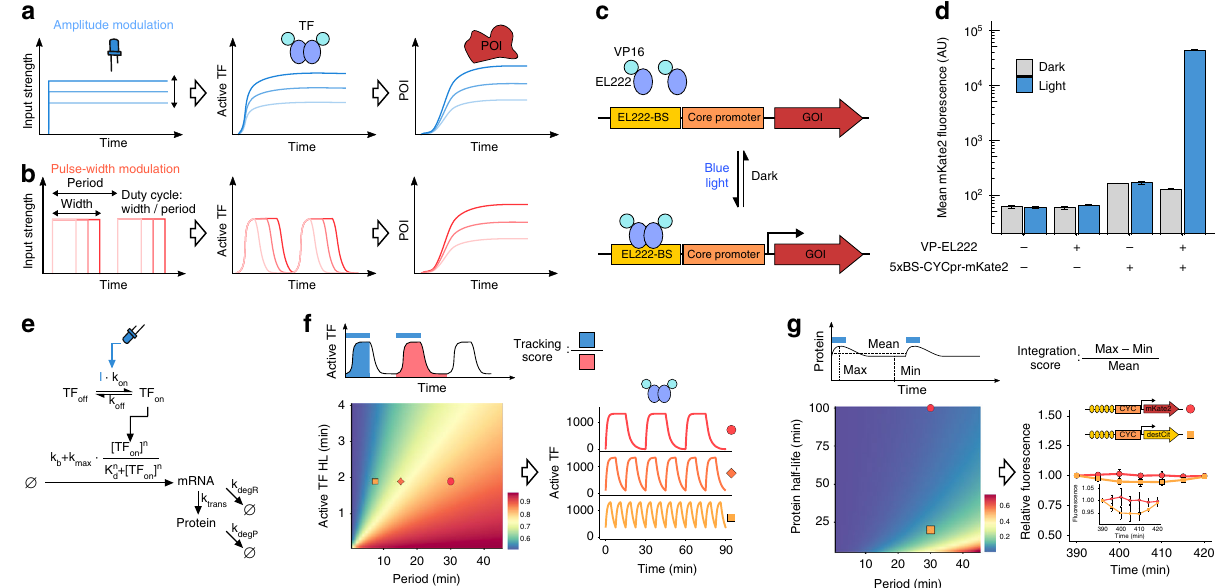
Fig. 1 Characterization of an EL222-based optogenetic gene expression system in S. cerevisiae . a and b Schematic of gene expression regulation by AM ( a ) and PWM ( b ). Input signals (left) lead to TF activation (middle) and expression of a protein of interest (POI, right). c Illustration of the optogenetic gene expression system. Blue-light triggers VP-EL222 dimerization and transcription of a gene of interest (GOI). d Effect of blue-light illumination on VP- EL222 mediated gene expression. Strains, with or without the VP-EL222 and a reporter construct (5xBS- CYC180 pr-mKate2), were grown either in the dark or under illumination (460 nm, 350 µ W cm − 2 ) for 6 h. Data represent mean and s.d. of three independent experiments. e Graphical representation of the model describing VP-EL222 mediated gene expression. I represents the light input. See Methods and Supplementary Note 1 for details. f Model-based analysis of pulsatile TF behavior. To quantify the temporal TF response, we use a tracking score de fi ned by the ratio between the integrated TF activity during the light pulse and the whole period (top, Supplementary Note 2). This metric is 1 if the TF activity perfectly tracks the input, and equals the duty cycle if TF activity does not change over time. The heatmap depicts the tracking score as a function of the PWM period and the half-life (HL) of the active VP-EL222 state (50% duty cycle, 420 µ W cm − 2 ). On the right, predicted temporal TF activities are shown for PWM conditions marked on the heatmap after an initial settling period (see Supplementary Note 2). g Model-based analysis of PWM-mediated protein expression. The heatmap depicts the integration score (top), quantifying temporal variations of protein levels (Supplementary Note 2), as a function of the PWM period and protein half-life (10% duty cycle). On the right, the measured time course of FP expression in response to PWM with a 30 min period are shown after 390 min of induction at 10% duty cycle. Experiments were performed using mKate2 (red) and a destabilized mCitrine variant 8,9 (yellow). Fluorescence is normalized by the value measured after 390 min. Inset differs in y -axis scaling. Data represent the mean and s.d. of two independent